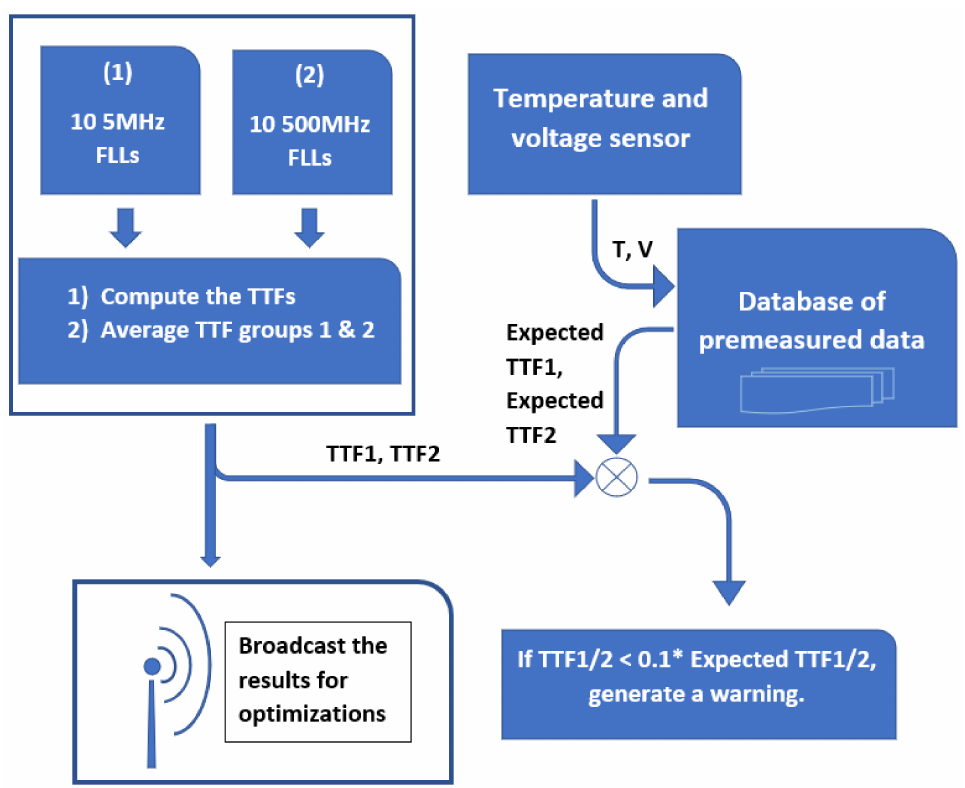
Figure 16. An operation flow of the MCM